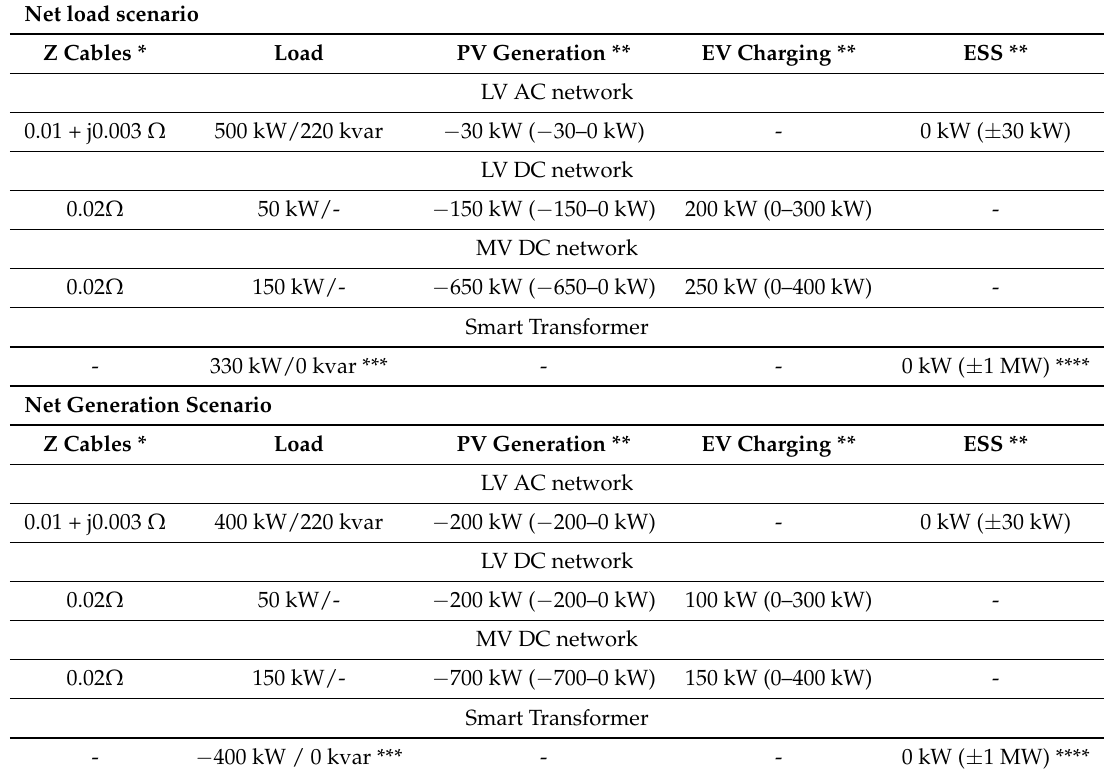
Table 3. Steady-state conditions and operation limits (nominal voltage and